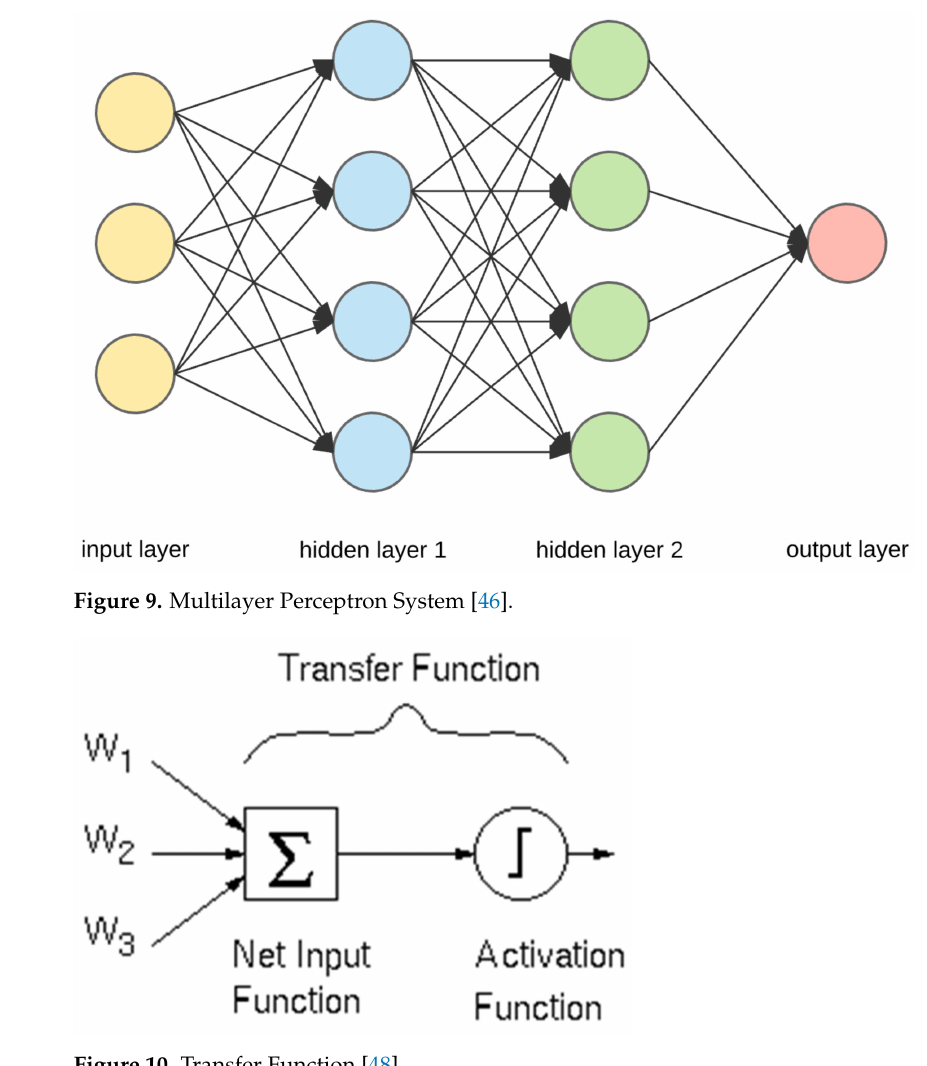
Figure 10. Transfer Function [48]. Table 8. Tuning Space for Hyperparameters in the ANN